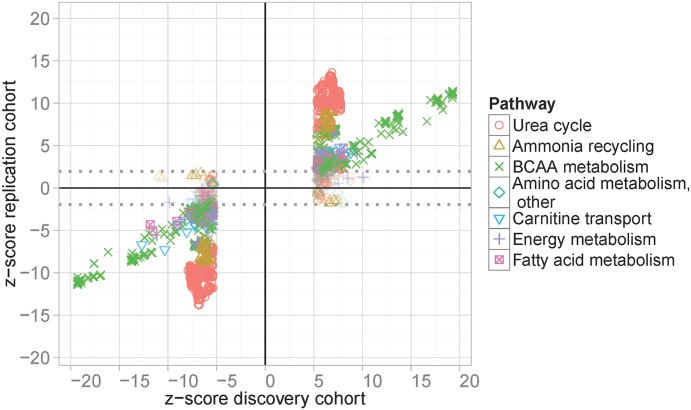
Results of replication analysis.GWAS top-hits of the LIFE Leipzig Heart study were compared with corresponding results in the Sorbs study. Top-hits were selected applying a p-value cut-off of p<1.0x10-7, which leads to the gap of z-scores at the x-axis. Associations below and above the dotted lines are considered as replicated controlling the false discovery rate at 5%. Colors and symbols correspond to physiologically related metabolites.